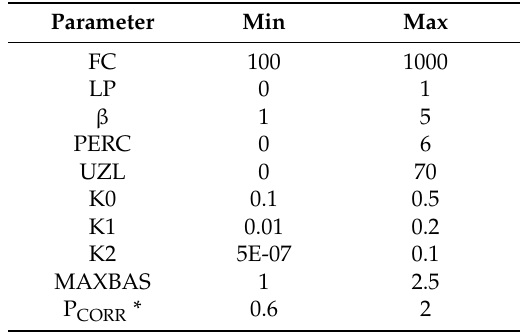
Table 2. Parameter ranges for GAP optimization of streamflow simulations in HBV-light.